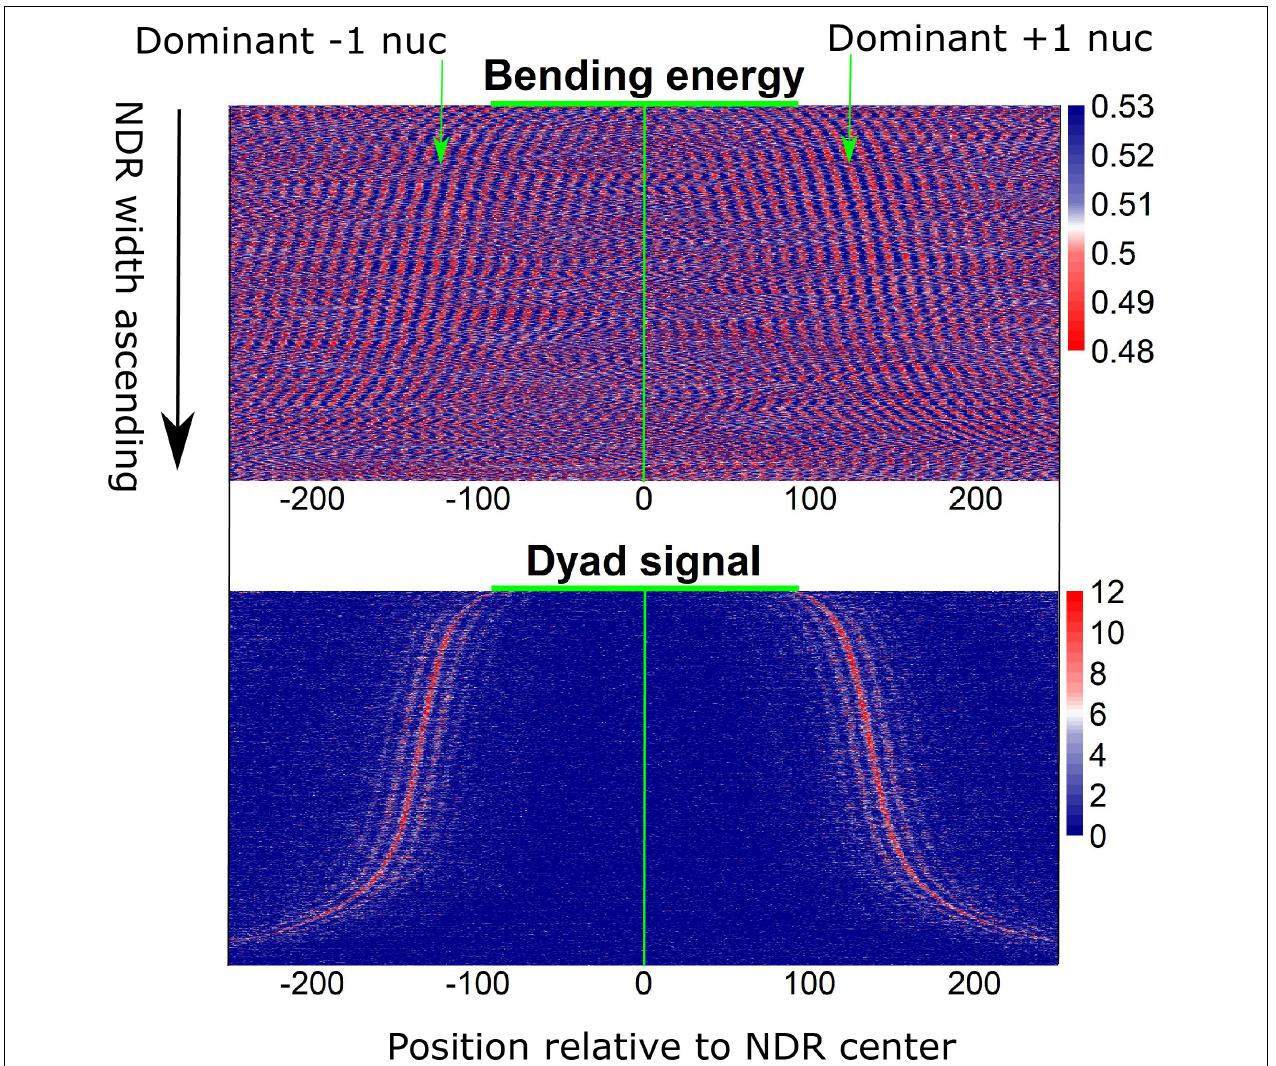
FIGURE 5 | Local bending energy minima coincide with the experimentally identified nucleosome positions around NDRs (Chereji et al., 2018), which differ by multiples of the helical turn and have the same rotational setting.